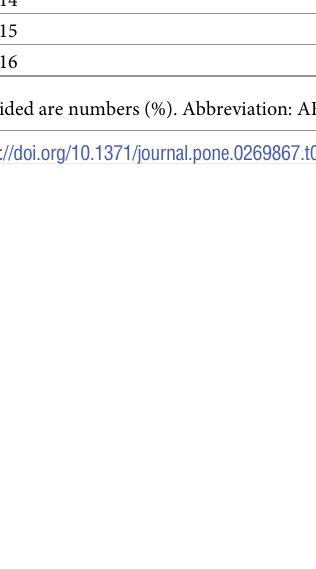
Model relatedness between original model and validation databases Patients with AF were more likely to have hypertension, heart failure or other cardiac condi- tions than controls in all validation datasets than the model development data. Certain